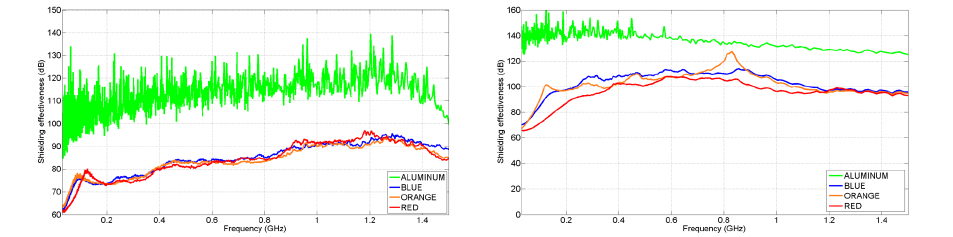
Figure 23. Shielding effectiveness measurement according to ASTM D4935 standard: before upgrad- ing the sample holder ( left ) and after upgrading the sample holder ( right ).